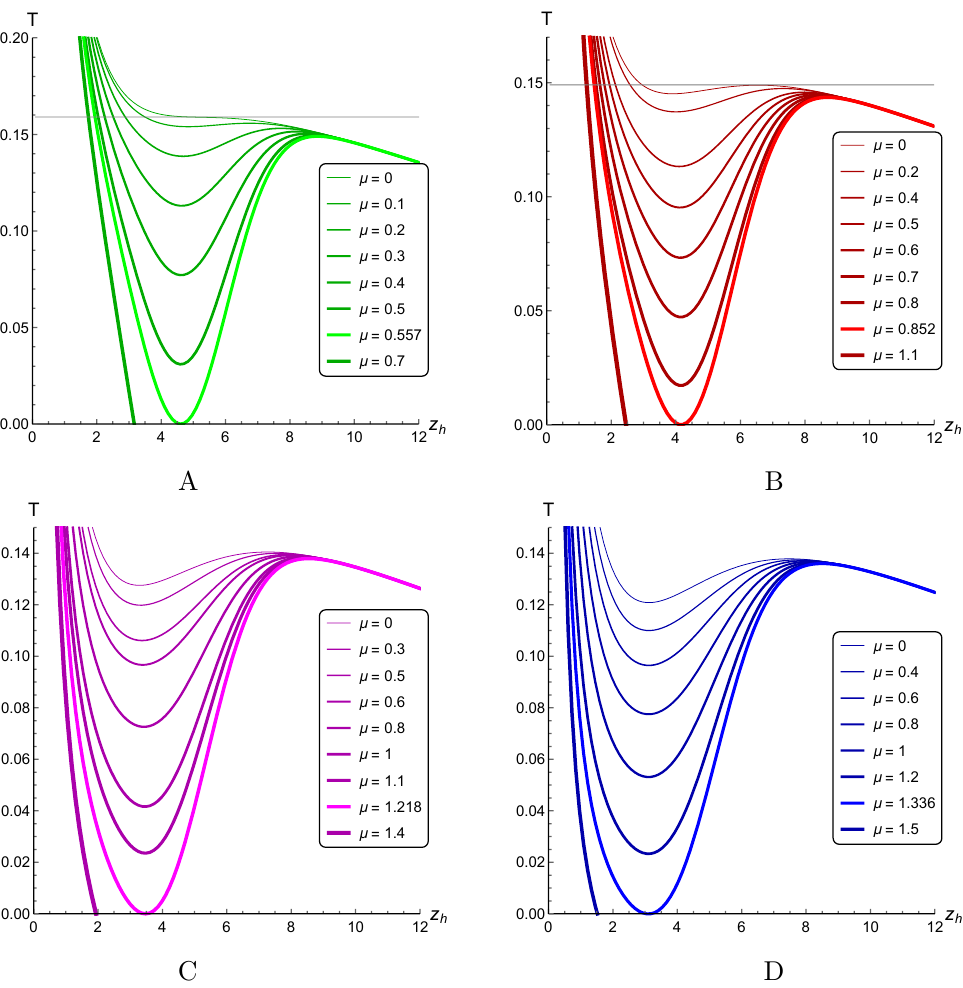
Figure 11 . Temperature as function of horizon for different µ in isotropic (A) and anisotropic cases for ν = 1 . 5 (B), ν = 3 (C), ν = 4 . 5 (D); a = 4 . 046 , b = 0 . 01613 , c = 0 . 227